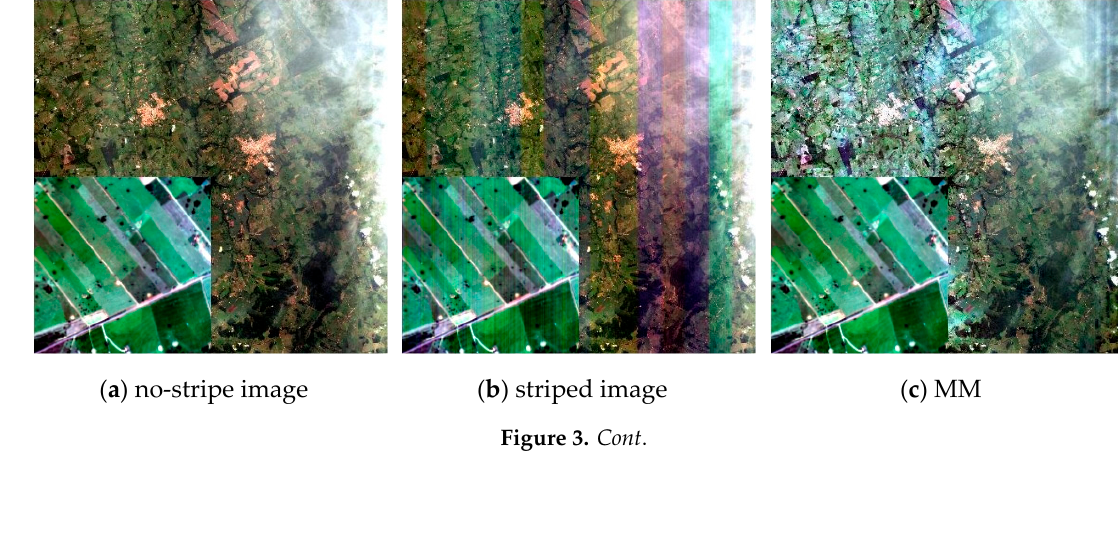
Table 1. Conditions of the experimental